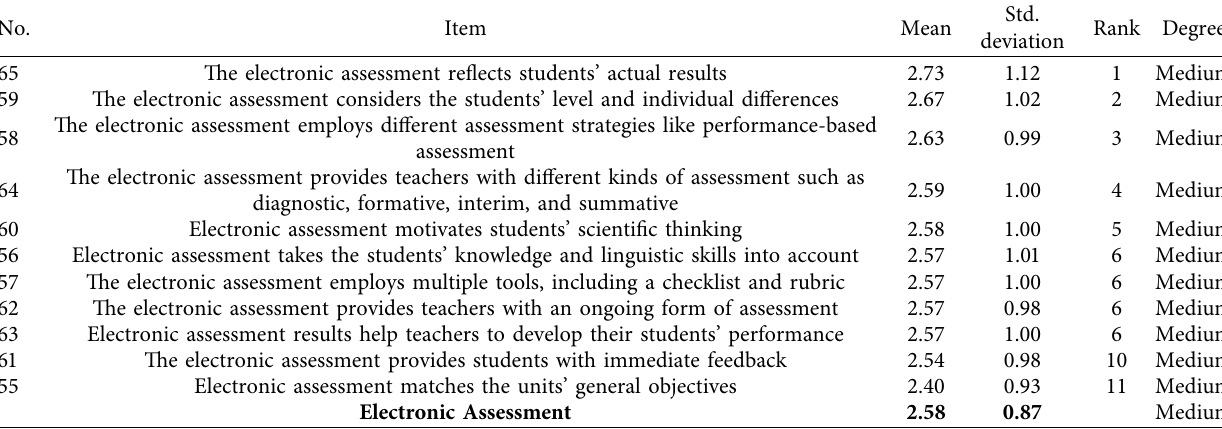
Table 2: Means, standard deviations, ranks, and degree of the study sample on the field of Electronic Assessment. No.